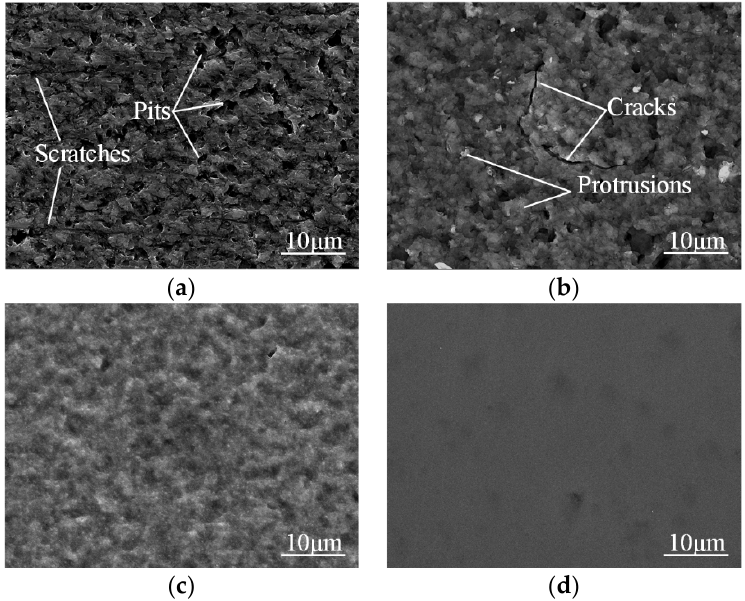
Figure 7. The scanning electron microscopy (SEM) images of single-crystal 4H-SiC surface: ( a ) Chemical cleaned surface; ( b ) After plasma electrolytic processing for 30 s; ( c ) After HF etching for 10 min; ( d ) After mechanical polishing for 5 min.